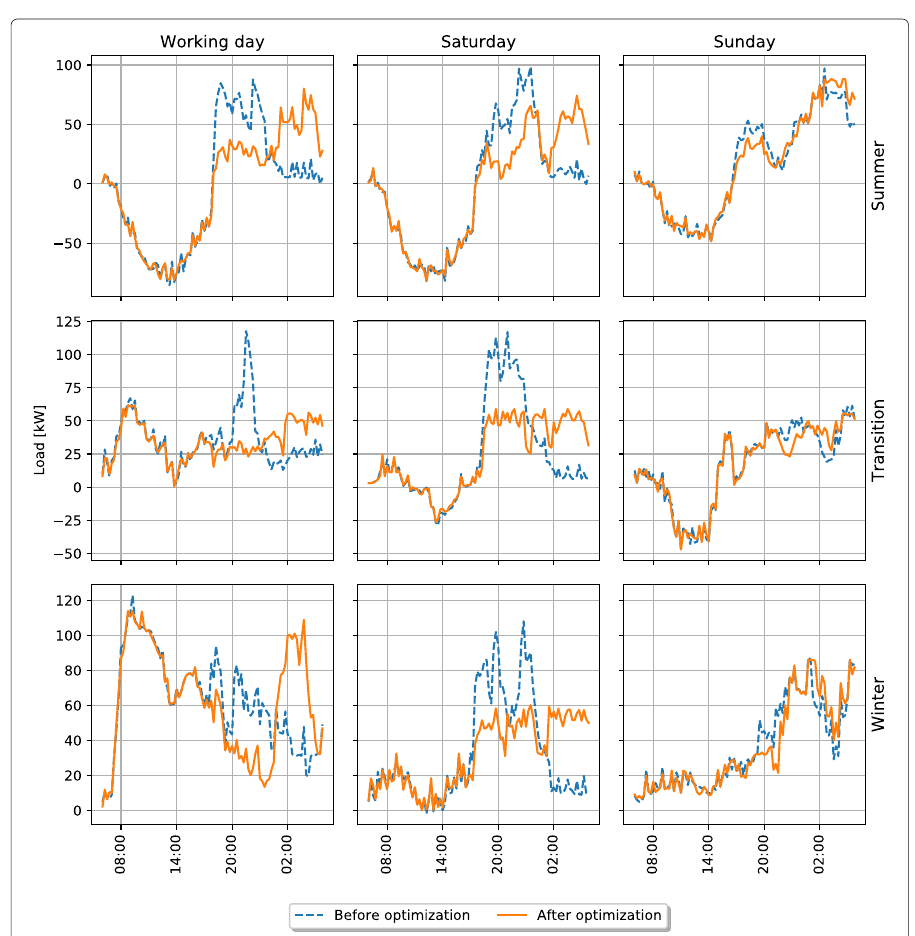
Fig.3 Simulationresults of the aggregatedload of 30 interconnected buildingswithinthe urban gridfor 2050